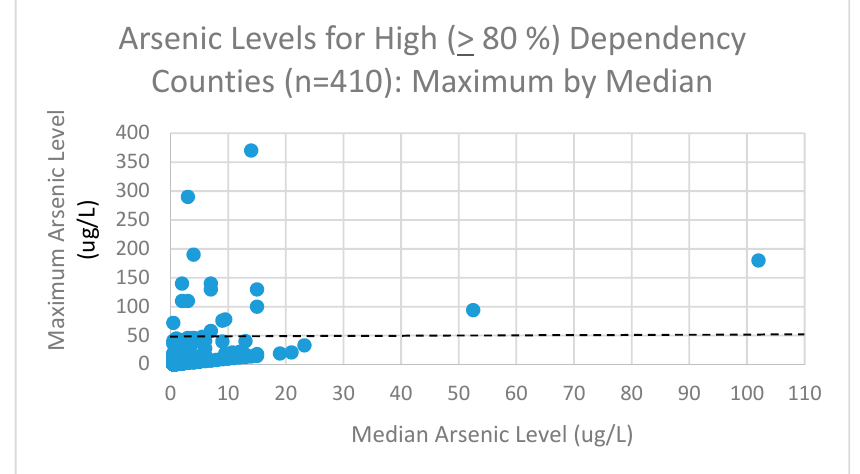
Figure 3. Maximum arsenic level by median arsenic level for high dependency (>80%) counties.